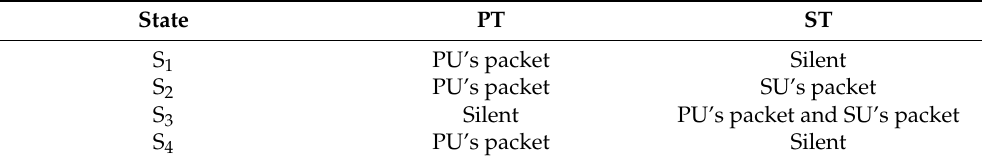
Table 1. Hybrid cooperative cognitive radio networks based on OMA/NOMA of transmission state.